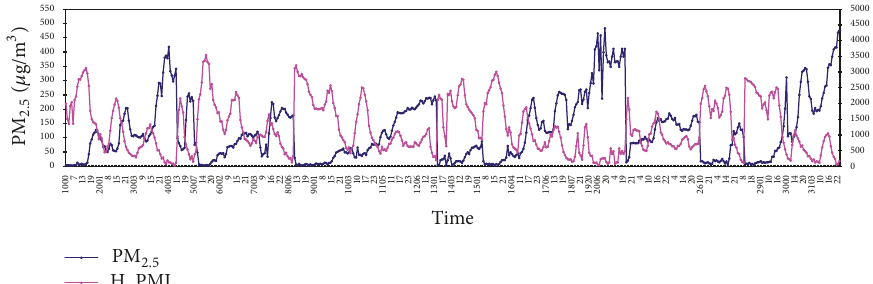
Figure 1: Hourly PM 2.5 observations and H PML in Beijing in the period of 1–31 December (542 synchronous observations patterns).